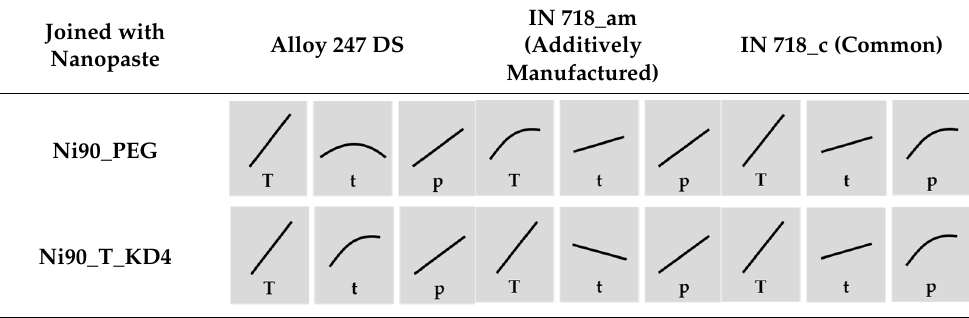
Table 5. Influence of joining parameters on shear strength as non-numerical charts (T: joining temperature, t: holding time, p: joining pressure).